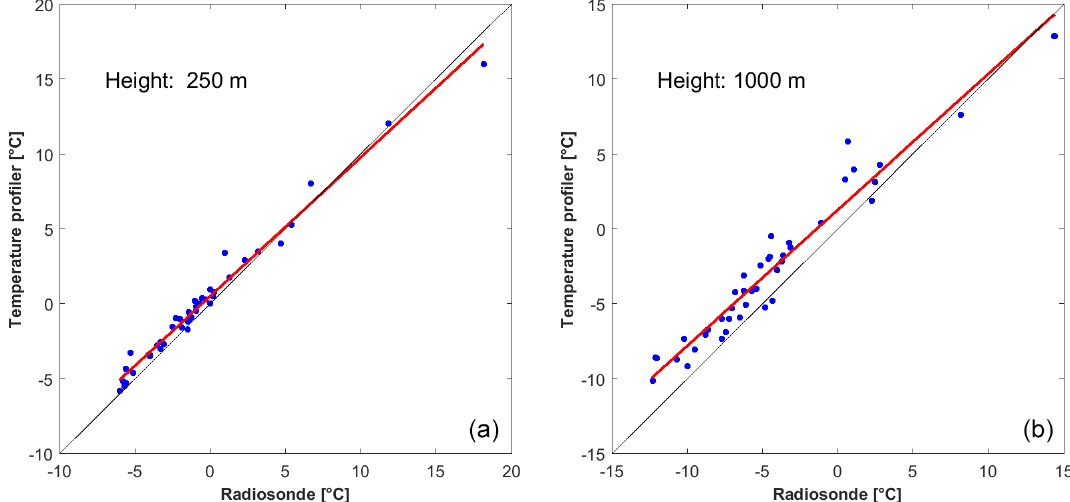
Figure 6. Linear regression between temperatures from radiosonde ascents and contemporaneous profiler records at two particular heights. For regression parameters, see Table